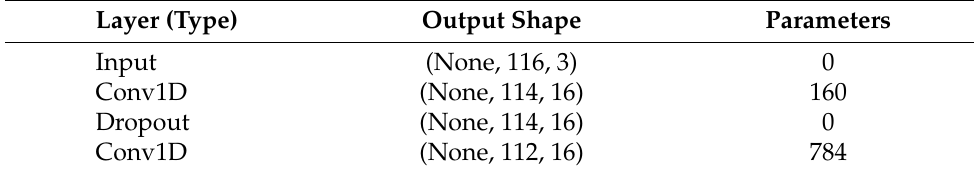
Table 4. Number of parameters of the CNN-LSTM